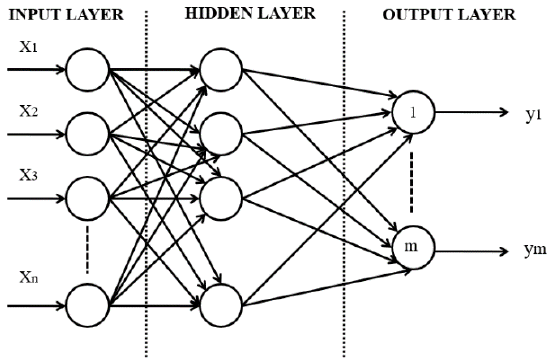
Table 5. Risk groups. Total Risk Score